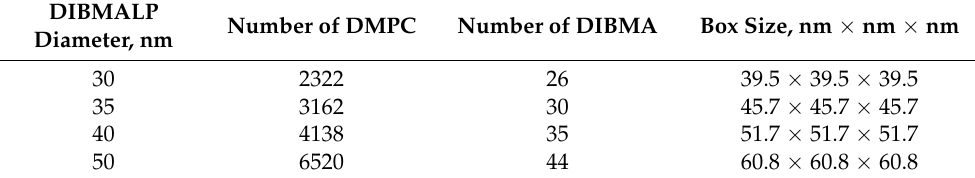
Table 2. Overview of the simulated